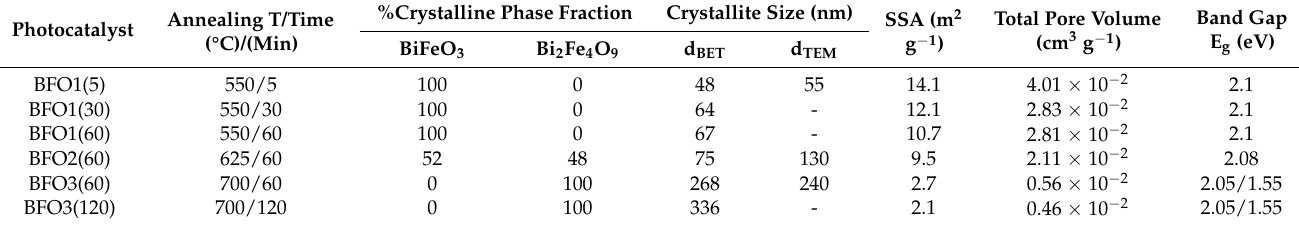
Figure 1. ( A ) XRD patterns for the BFO1(5), BFO2(60), BFO3(60) materials. The reference Miller- planes’ reflections for BiFeO 3 and Bi 2 Fe 4 O 9 phases are shown in the graph’s top. ( B ) TEM images, ( C ) Percentage of crystalline phases, and SSA for the various annealing protocols (see details in Table 1). Table 1. Structural Characteristics of the present FSP-made BFO